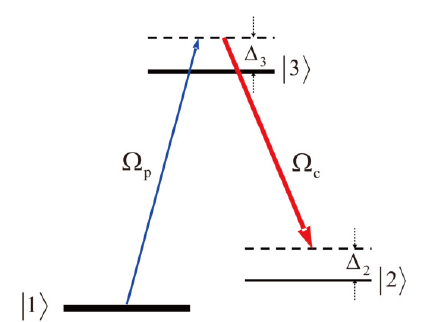
Figure 1. (Color online) Excitation scheme of the lifetime broadened three-state atomic system interacting with a weak probe field with the half Rabi frequency Ω p , and a strong continuous-wave control field with the half Rabi frequency Ω c